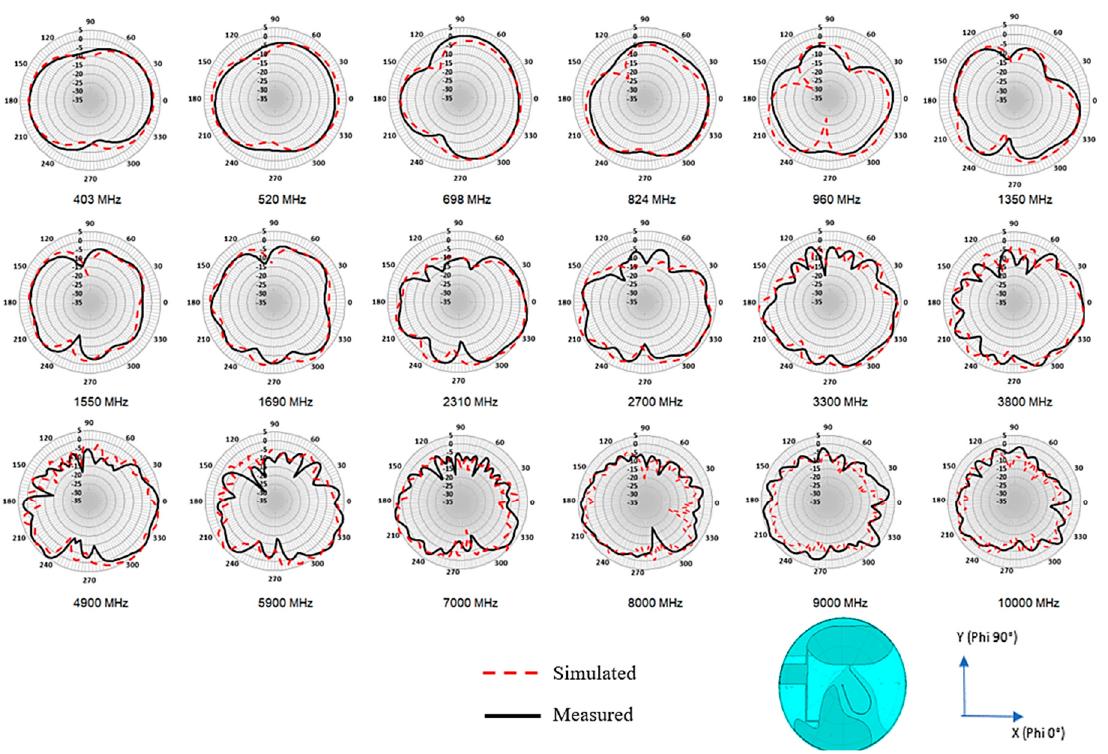
Figure 25. Measurement setup in ( a ) Satimo SG24 (350–6000 MHz measurement) and ( b ) Satimo Starlab (7000–10,000 MHz) for the radiation pattern measurement of the antenna.